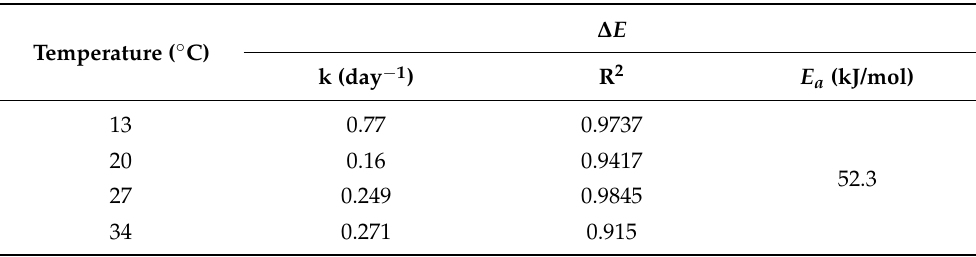
Figure 4. Plot of the response function F ( X ) with storage time for ∆ E value of indicator label applied with mango fruit at different temperatures. Table 3. Response of rate constants ( k ), the correlation coefficient ( R 2 ) of the fit and activation energy ( E a ) obtained from the ∆ E model.